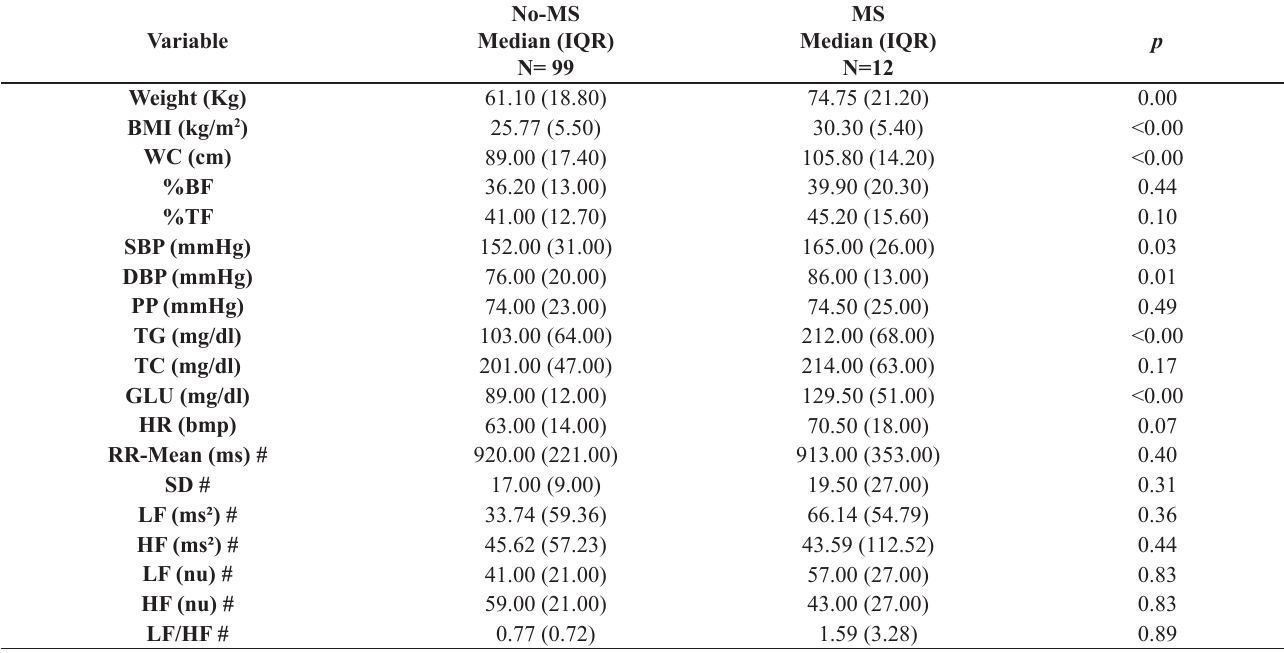
Table 4. Comparison between metabolic syndrome and no-metabolic syndrome elderly aged 80 years old and over.